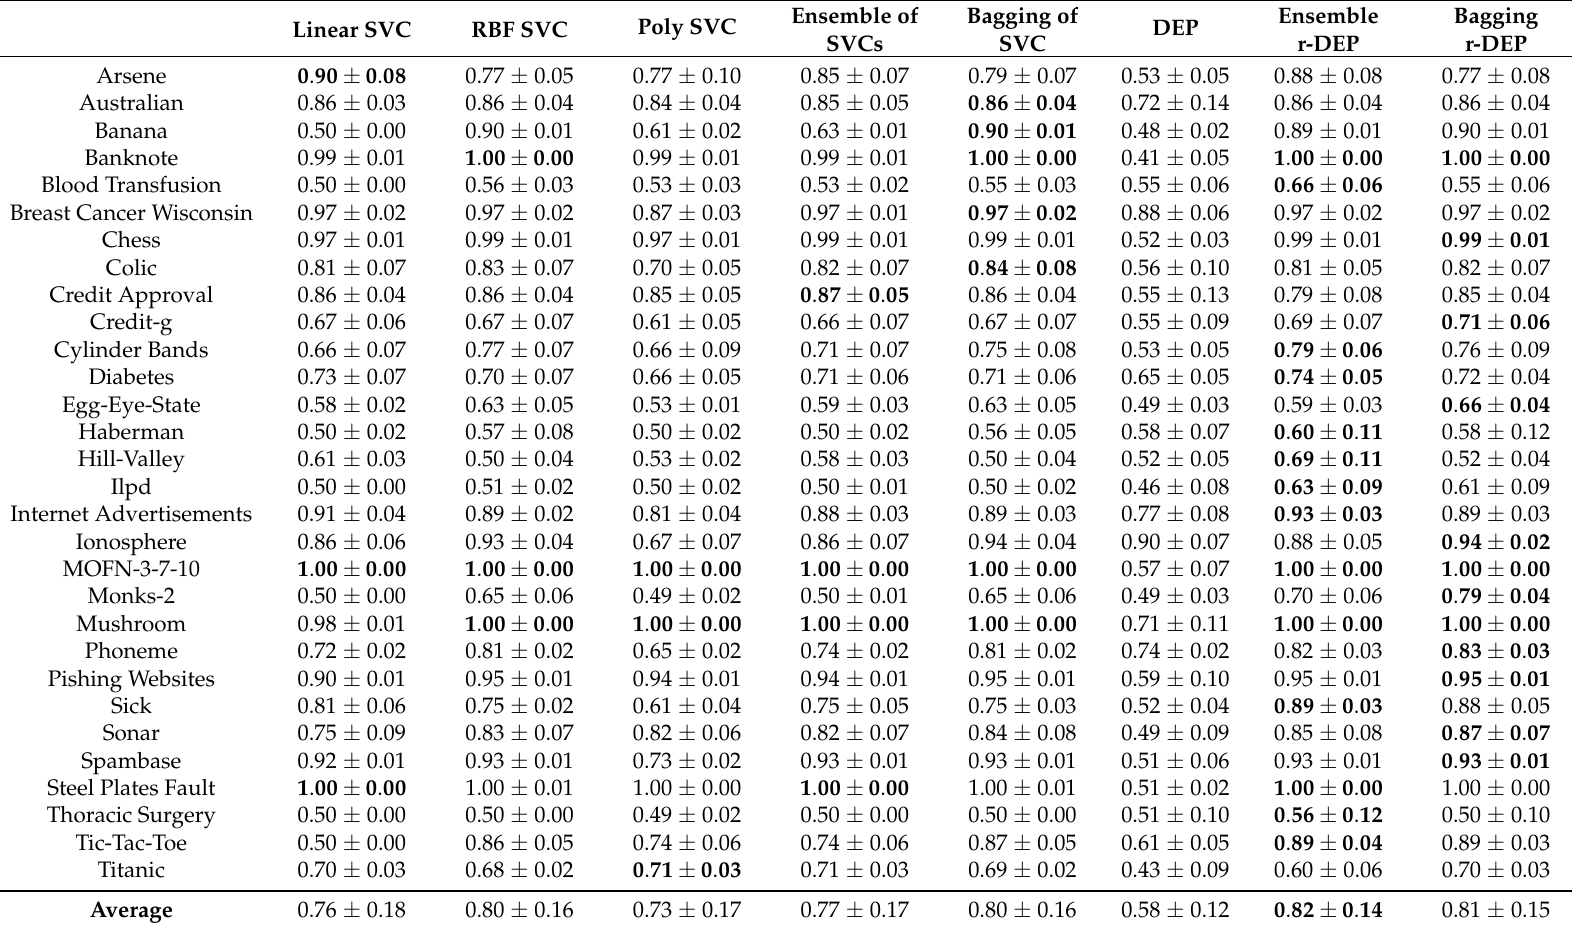
Table 4. Average and standard deviation of the balanced accuracy scores obtained from the classifiers using stratified 10-fold cross-validation. The largest average score for each dataset have been typed using